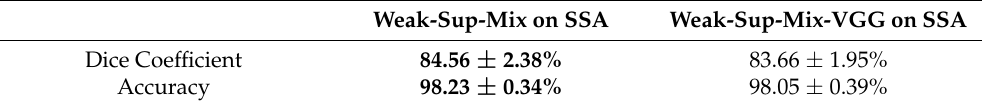
Table 5. Average test-set scores and standard deviation using 10-fold cross-validation on the 90 sessile serrated adenoma images with human-labeled segmentation